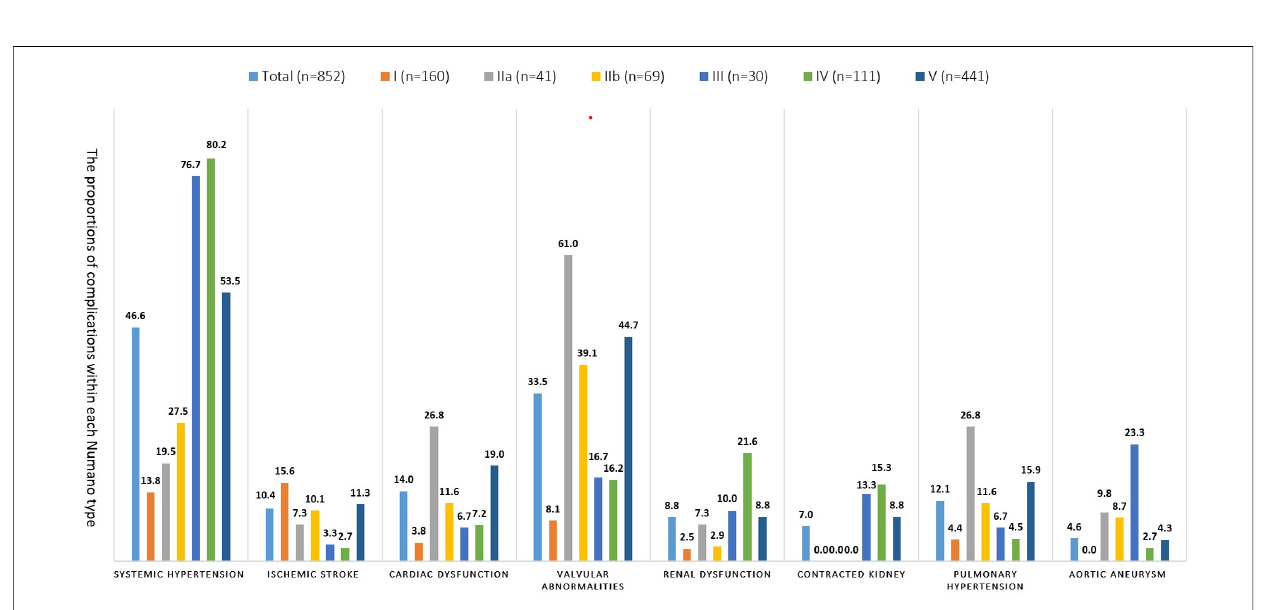
FIGURE 3 The prevalence of complications within each Numano type in Chinese TA patients. Legend: This fi gure shows the prevalence of the eight complications that were signi fi cantly different among the six Numano angiographic patterns. The horizontal axis represents the types of complications, and the vertical axis represents the prevalence of complications. The columns with different colors indicate the group of the total sample and the different subgroups of the Numano angiographic